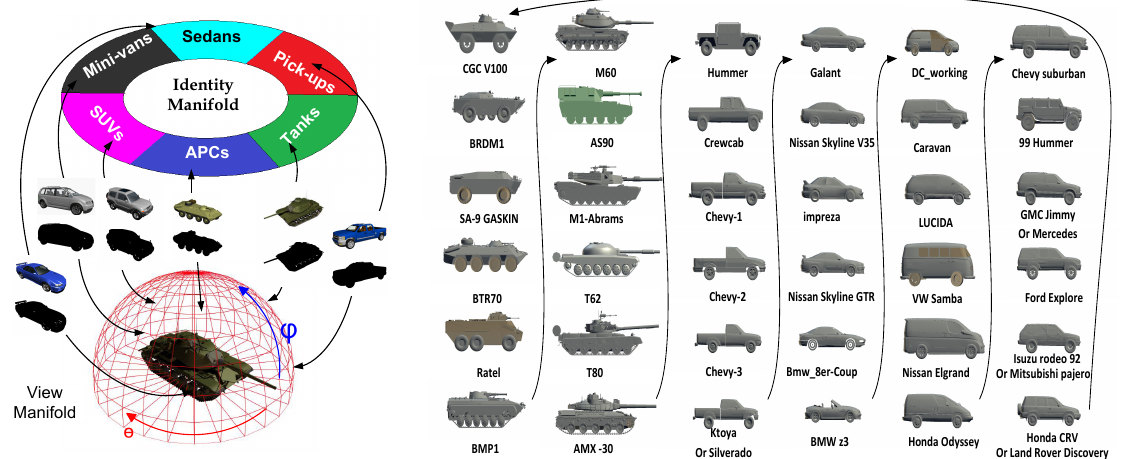
Figure 4. CVIM learning. ( Left ) The couplet of view and identity manifold (CVIM) shape generative model [33]; ( Right ) six CVIM CAD training models for each of six target